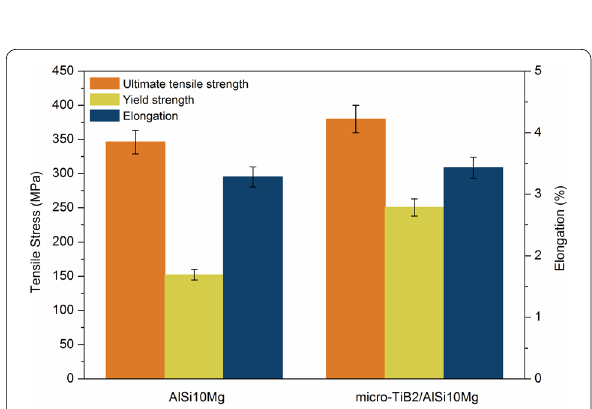
Figure 10 The tensile properties of the unreinforced SLM-processed AlSi10Mg alloy and TiB 2 /AlSi10Mg samples including ultimate tensile strength, yield strength and